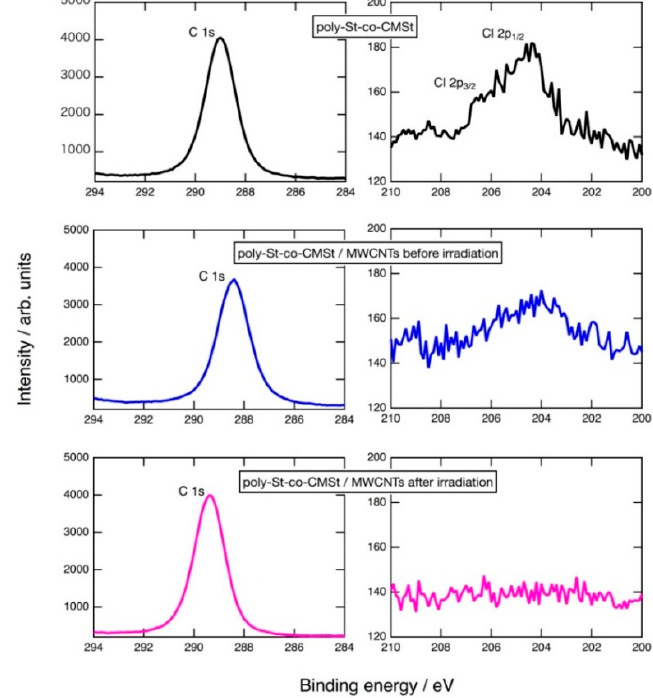
Figure 3. C 1s and Cl 2p X-ray photoelectron spectra observed for intact styrene/p-(chloromethyl)styrene random copolymer (poly-St-co-CMSt) and for poly-St-co-CMSt/multi-walled carbon nanotube mixture before and after ultraviolet